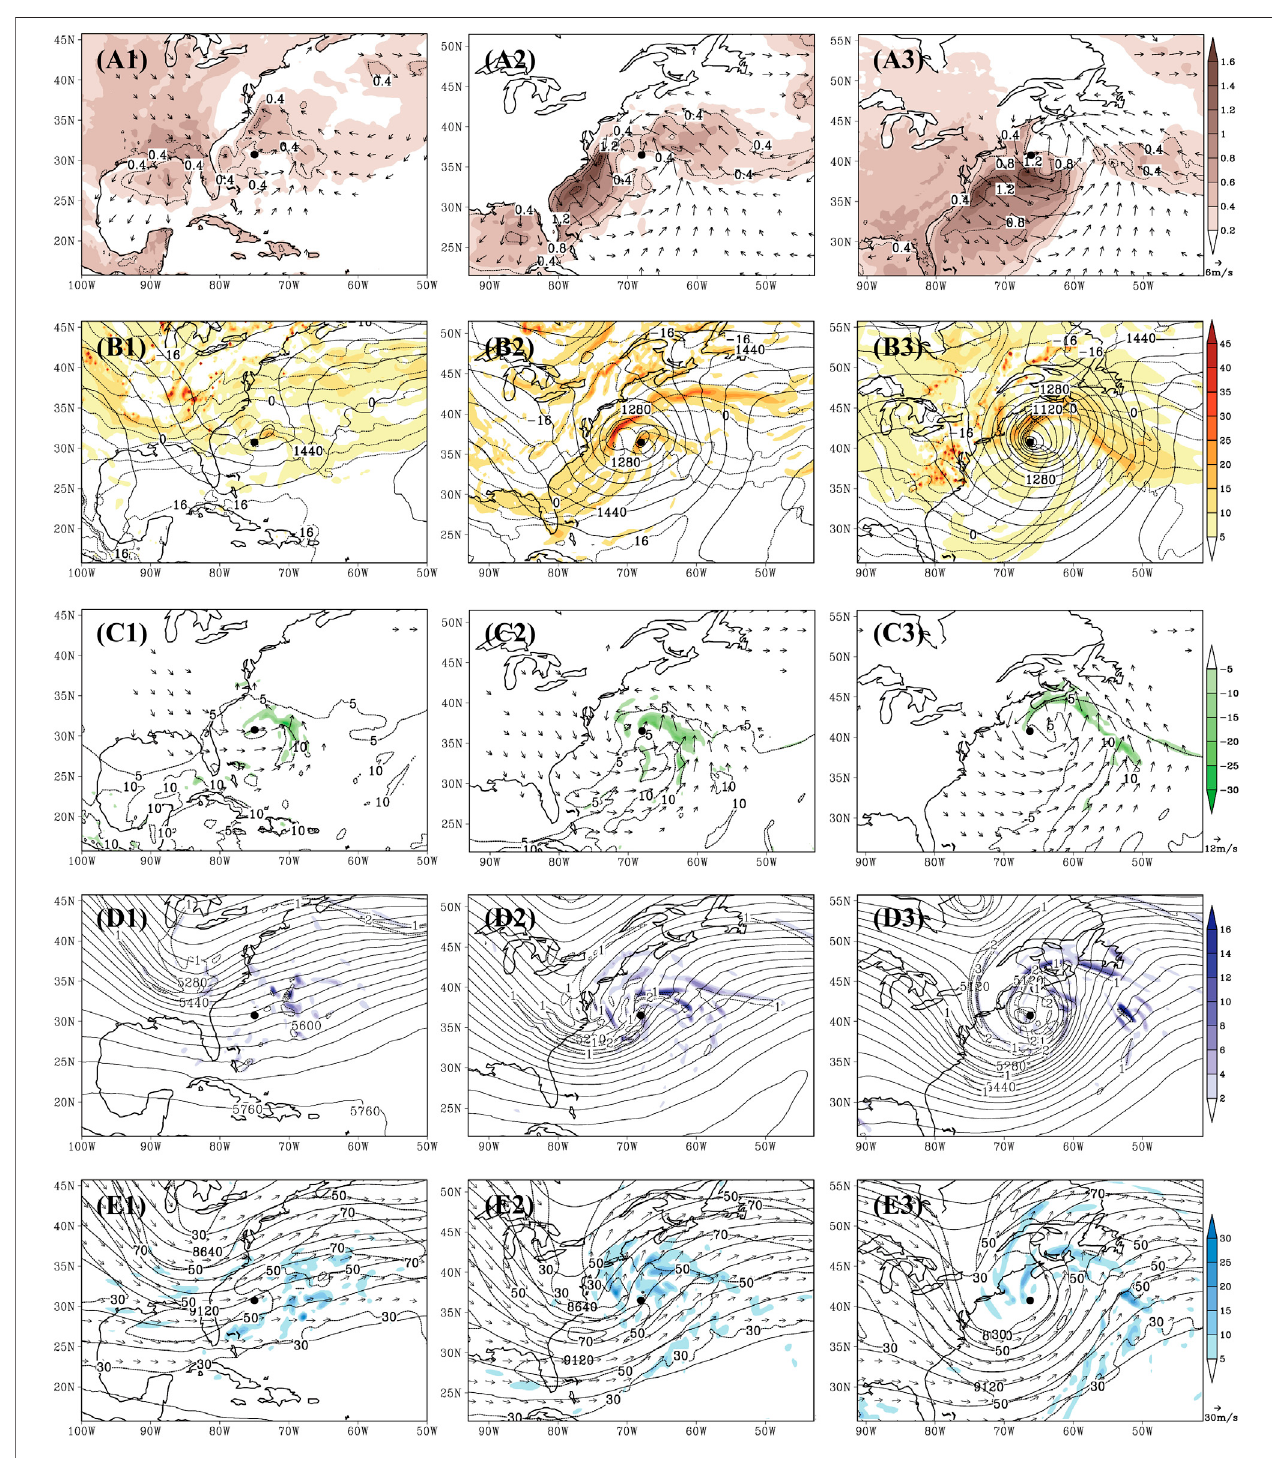
FIGURE 3 | Synoptic weather charts at (A1 – E1) 18 UTC 25, (A2 – E2) 06 UTC 26, and (A3 – E3) 18 UTC March 26, 2014. (A1 – A3) Surface heat fl uxes (latent and sensible fl uxes, shaded, 0.2 kW m − 2 intervals), evaporation (dashed, 0.4 mm intervals) and 10 m wind vector (arrow, ≥ 6 m s − 1 ); (B1 – B3) 850-hPa geopotential height (solid, 40 gpm intervals), temperature (dashed, 4 ° C intervals) and Eady growth rate (shaded, 5 × 10 − 6 s − 1 intervals); (C1 – C3) 850-hPa jet stream (arrow, ≥ 12 m s − 1 ), speci fi c humidity (dashed, 5 g kg − 1 intervals) and water vapor convergence (shaded, 5 × 10 − 4 g kg − 1 s − 1 intervals); (D1 – D3) 500-hPa geopotential height (solid, 40 gpm intervals), vorticity (dashed, 1 × 10 − 4 s − 1 intervals) and vorticity advection (shaded, 2 × 10 − 9 s − 2 intervals); (E1 – E3) 300-hPa geopotential height (solid, 120 gpm intervals), wind vector (arrow, ≥ 30 m s − 1 ), jet stream (dashed, ≥ 30 m s − 1 ) and divergence (shaded, 3 × 10 − 5 s − 1 intervals). The large solid dot denotes the SEC center.